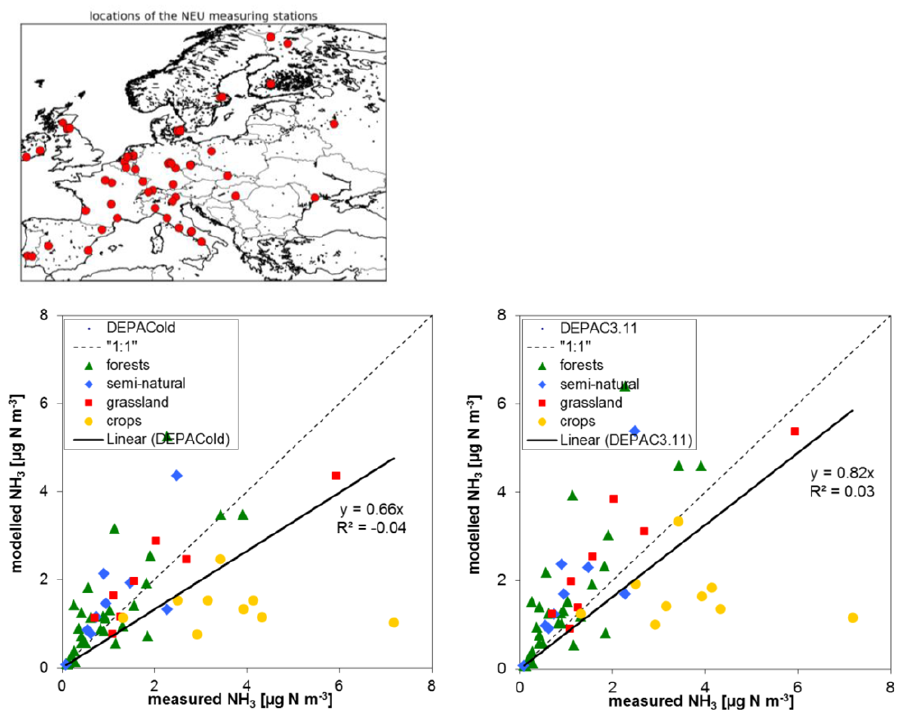
Fig. 10. Comparison of the modeled ammonia concentrations for 2007 using the DEPACold (left figure) and DEPAC3.11 (right figure) surface–atmosphere exchange modules with the measured concentrations of the NitroEurope measurement network ( n = 55) for 2007–2008 (Flechard et al., 2011). The grid resolution of the model results is 0.50 ◦ longitude × 0.25 ◦ latitude ( ∼ 28 × 28km 2 ) . The stations in the NitroEurope network are classified into four different land-use classes (forest, semi-natural, grassland and